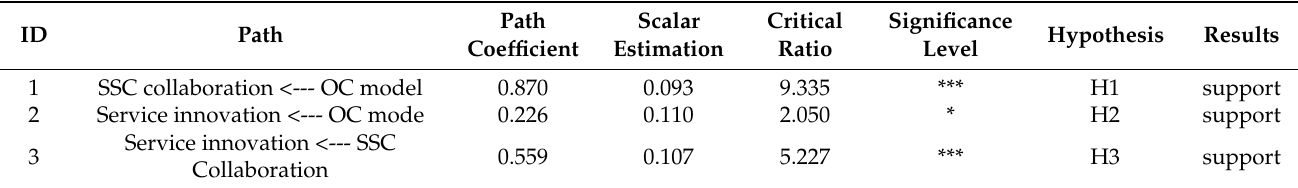
Table 6. Hypothesis test